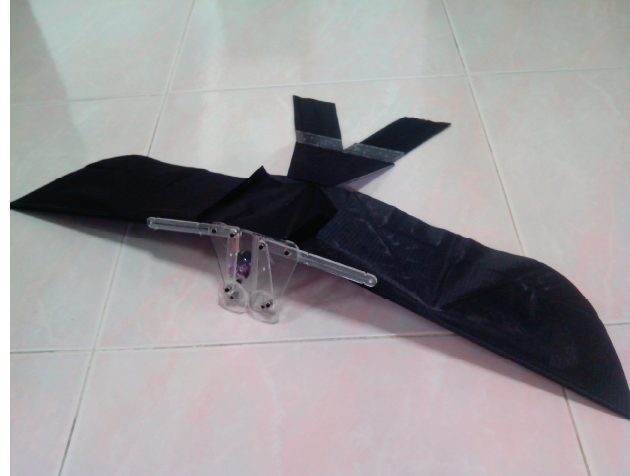
Figure 56. Assembled flapping wing MAV.